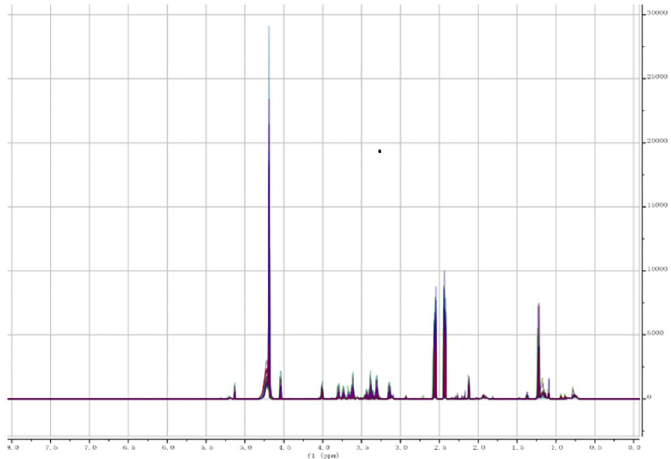
Fig 1. CBO’s spectrums.